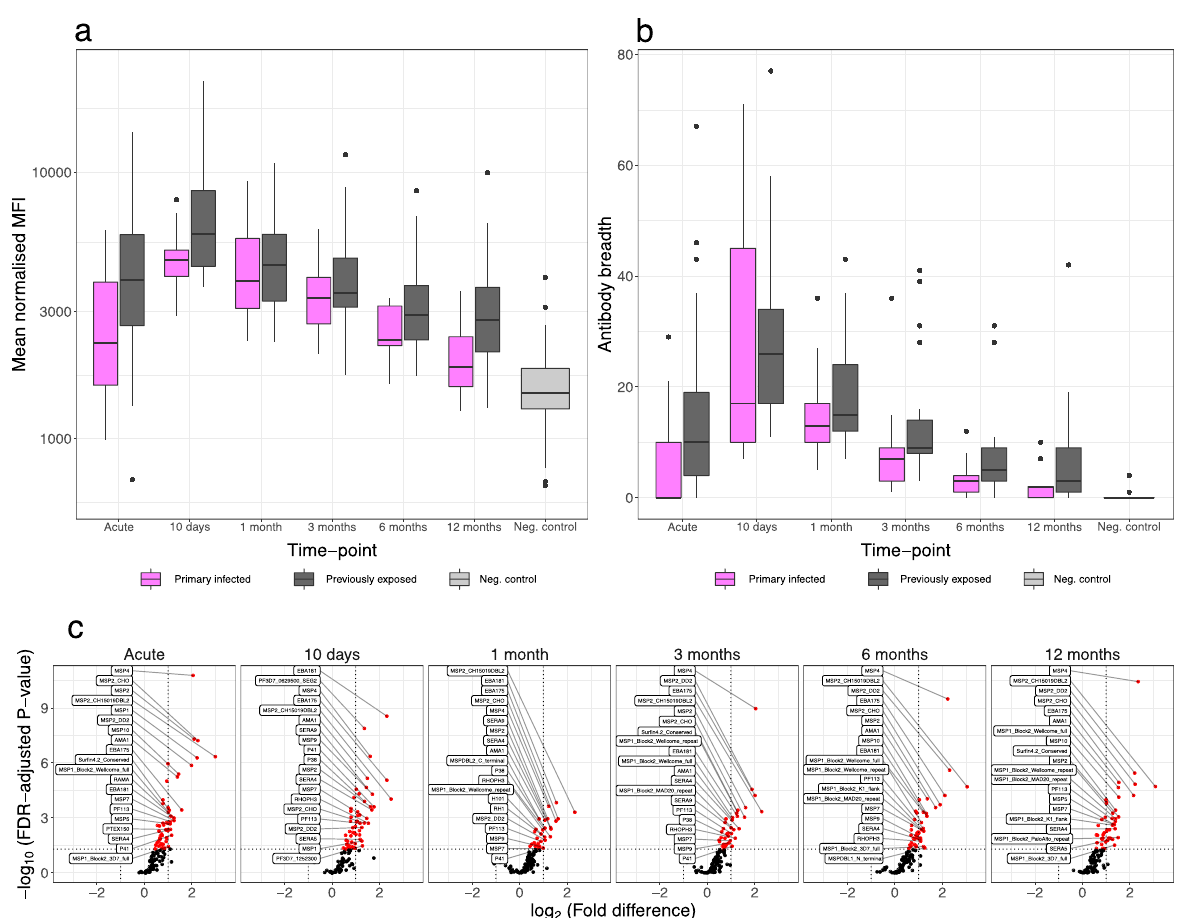
Fig. 2 Differences in average antibody reactivity related to prior exposure. a Box-plot of the overall magnitude of the antibody response to P. falciparum over time (averaging signal intensities over all antigens for each individual) in individuals with prior malaria exposure (grey; 111 antibody responses ( a ) measured in 149 samples ( s ) from 41 unique individuals ( n )) or without prior malaria exposure (magenta, a = 111, s = 91, n = 24) and in negative controls (light grey, a = 111, s = 42, n = 42). b Box-plot of the breadth of the response over time in individuals with (grey, a = 111, s = 149, n = 61) or without (magenta, a = 111, s = 91, n = 24) prior malaria exposure and in negative controls (light grey, a = 111, s = 42, n = 42). The breadth is expressed as the total number of antigens to which the individual responds. The centres of boxes correspond to the median. The lower and upper hinges of boxes correspond to the fi rst and third quartiles of the data. The upper and lower whiskers extend from the hinges to the largest and smallest values, respectively, no further than 1.5 * the interquartile range from the hinges. Data beyond the end of the whiskers are plotted individually. c Volcano plot of the fold-difference in geometric mean antibody reactivity between individuals with or without prior malaria exposure vs. the false discovery rate (FDR)-adjusted p -value at each of the sampling time-points. Linear mixed-effect regression models fi tted to the Log-transformed antibody data were used to estimate the mean fold- difference of the response for each antigen between primary infected and previously exposed participants. P -values were FDR-adjusted for multiple comparisons using the procedure described by Benjamini and Hochberg. A log 2 (fold-difference) of greater than 0 indicates antigens to which the geometric mean response is greater among previously exposed individuals and conversely a log 2 (fold-difference) of less than 0 indicates antigens to which the geometric mean response is greater among primary infected individuals. Antibody responses that differ signi fi cantly between exposure groups are highlighted in red and the 20 antigens for which the difference is greatest are named in the fi gure. Further details are included within the supplementary information (Supplementary Data